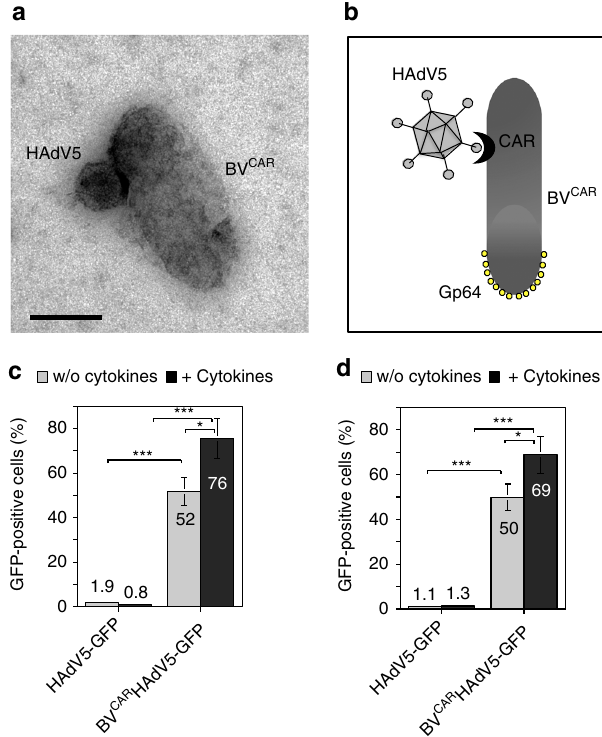
Fig. 1 Vector duo and transduction of human and rat synoviocytes. a The BV CAR HAdV5 binary complex can be visualize by electron microscopy. The HAdV5 vector with a icosahedral shape, is bound to BV CAR , a rod-shaped baculovirus which has incorporated the CAR glycoproteins in its envelope. Scale bar, 100 nm. b The schematic representation shows the BV CAR HAdV5 binary complex, with HAdV5 bound to BV CAR via the CAR glycoprotein at the baculoviral membrane. The baculoviral envelope glycoproteins Gp64 are localized at the head of the baculoviral particle. c Human and d rat fi broblast-like synoviocytes (FLS) non-treated ( grey bars ) or pre-treated ( black bars ) with the proin fl ammatory cytokines were transduced with HAdV5-GFP alone, or with the BV CAR HAdV5-GFP complex. The fi gures represent the percentage of GFP-positive FLS cells analysed by fl ow cytometry. The average of three independent experiments, each in triplicates are shown. Statistical analysis using one- way ANOVA test, *** P < 0.001, ** P < 0.01, * P <